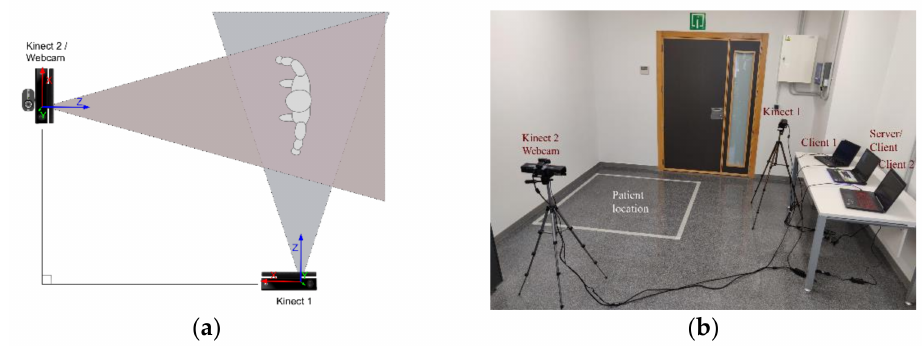
Figure 3. Our system: ( a ) Cameras distribution, ( b ) Working